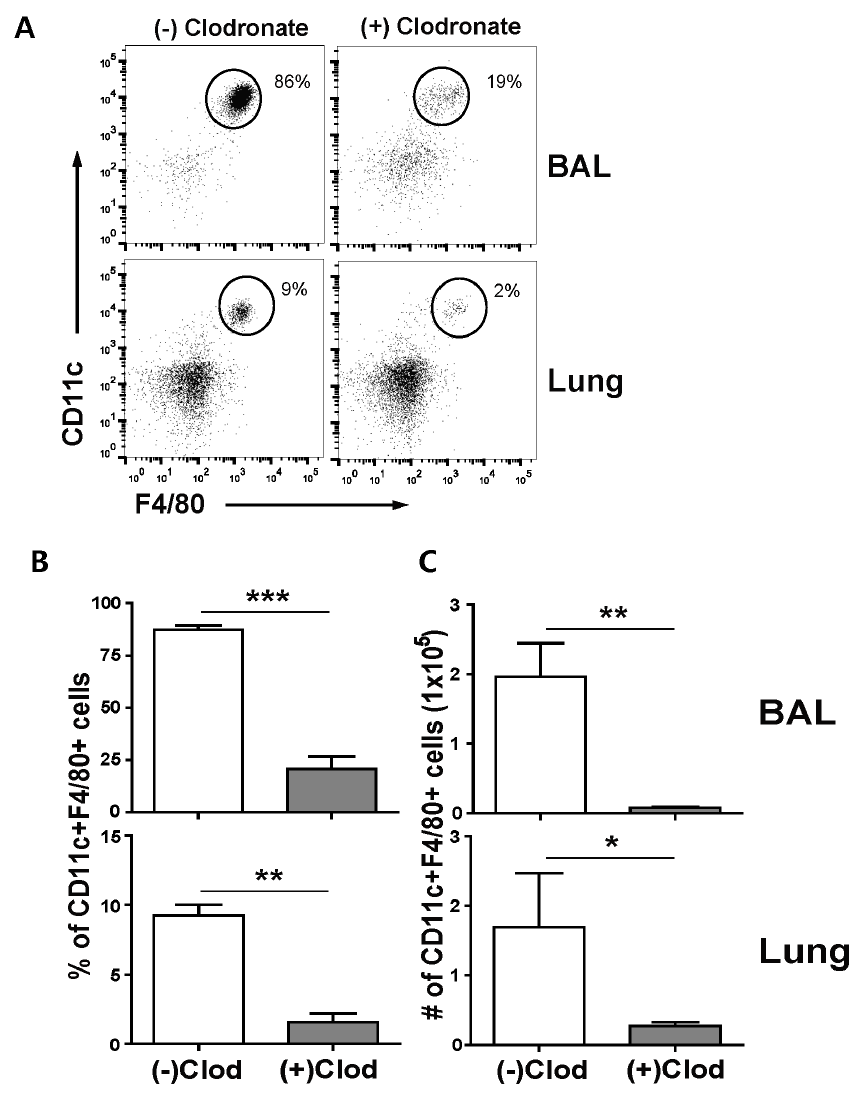
Figure 11. Intranasal administration of clodronate-liposomes selectively depletes CD11c + F4/80 + alveolar macrophages in lungs and bronchoalveolar lavages. The cells from the bronchoalveolar lavage (BAL) and lungs from mice (n=3) were harvested4 days after clodronate injection. CD3 + and CD11b + cells were excluded to determine the effect of clodronate on depleting alveolar macrophages with CD3 2 CD11b 2 CD11c + F4/80 + markers. (A) Representative profiles of flow cytometry gating of CD3 2 CD11b 2 CD11c + F4/80 + phenotypic cells. (B) Percentages of CD3 2 CD11b 2 CD11c + F4/80 + cells. (C) Cellularity of CD3 2 CD11b 2 CD11c + F4/80 + cells. ( 2 ) Clodronate or ( 2 )Clod: No clodronate control mice, ( + ) Clodronate or ( + )Clod: Clodronate treated mice. BAL: Bronchoalveolar cells, Lung: Cells collected from lung tissues. *P , 0.05, **P , 0.001, ***P , 0.0001 (Student T-test). Bars indicate standard errors.